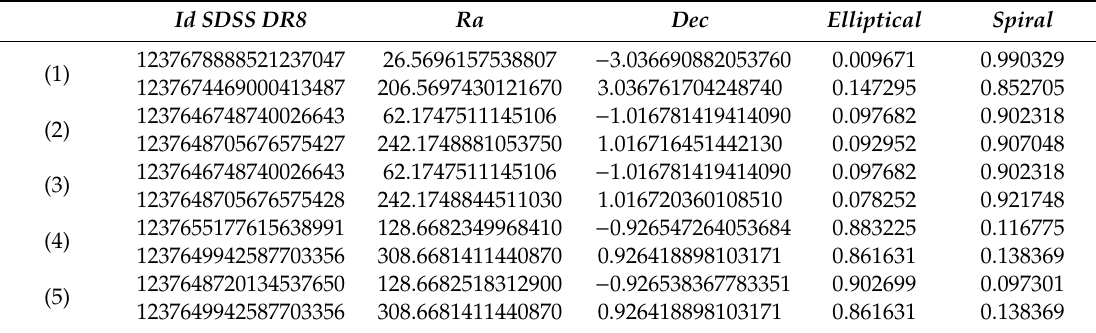
Table 5. Pairs of galaxies for the e ff ect of cosmic lens [40]. Id SDSS DR8—objID identification number in the Sloan Digital Sky Survey. Accuracy is of 0.00015 ◦ for ra and dec